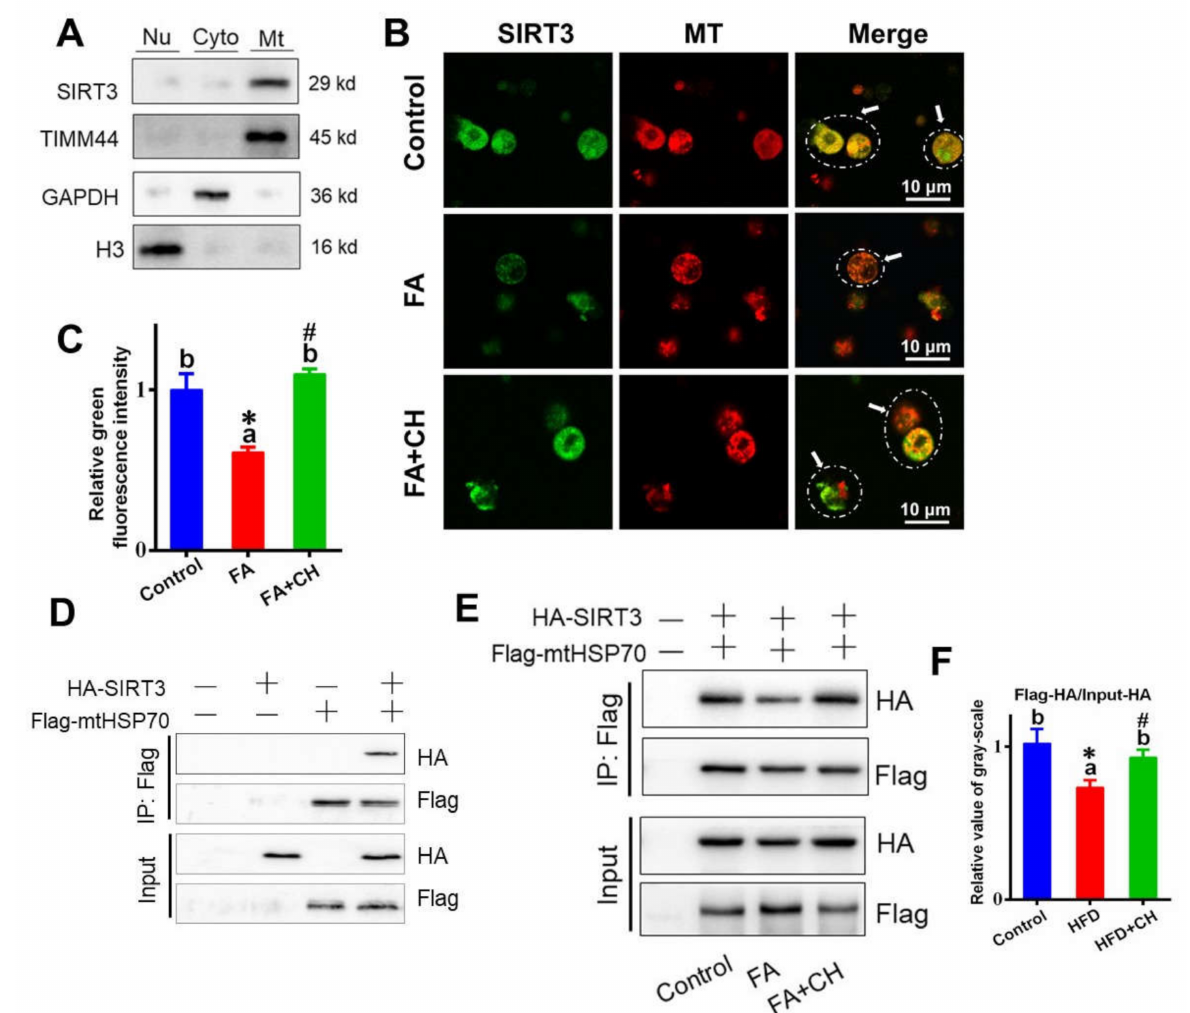
Figure 3. Choline improved the subcellular localization of SIRT3 into the mitochondria (MT) and alleviated the FA-reduced interaction of SIRT3 with mtHSP70 in vitro. ( A ) Western blot-analyzed subcellular localization of SIRT3 in hepatocytes of yellow catfish. Timm, mitochondrion marker; GAPDH, cytoplasm marker; H3, nucleus marker. ( B ) Co-localization analysis of SIRT3 (green) and mitochondria (red) (bars = 10 µ m) in hepatocytes of yellow catfish. Arrows indicate the regions of co-localization of SIRT3 and mitochondria. ( C ) Quantitative analysis for relative green intensity of fluorescence in B. ( D , E ) Interaction of mtHSP70 with SIRT3 without/with FA and choline